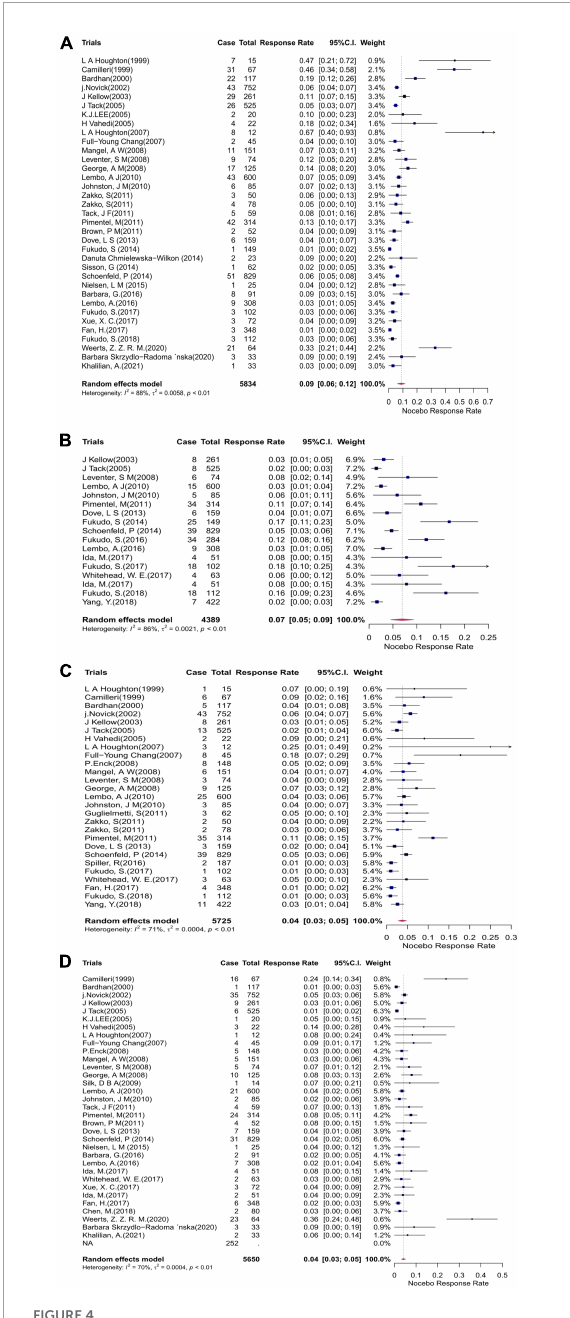
FIGURE4 Forest plots showing the cumulative event rates of (A) headache, (B) nasopharyngitis, (C) abdominal pain, and (D) nausea in the placebo arms of the clinical trials. CI, confidence